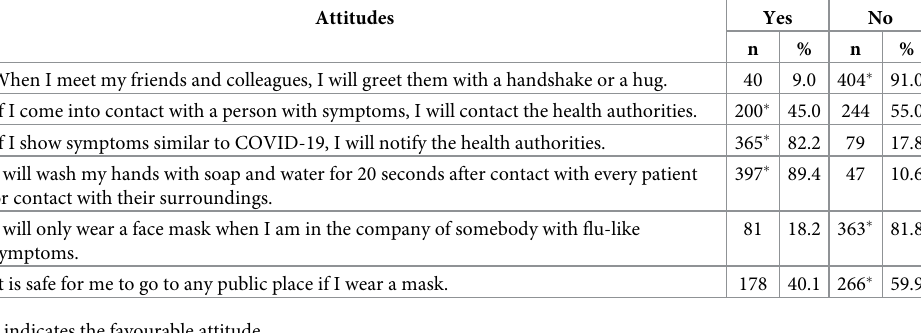
Table 5. Attitudes during the COVID-19